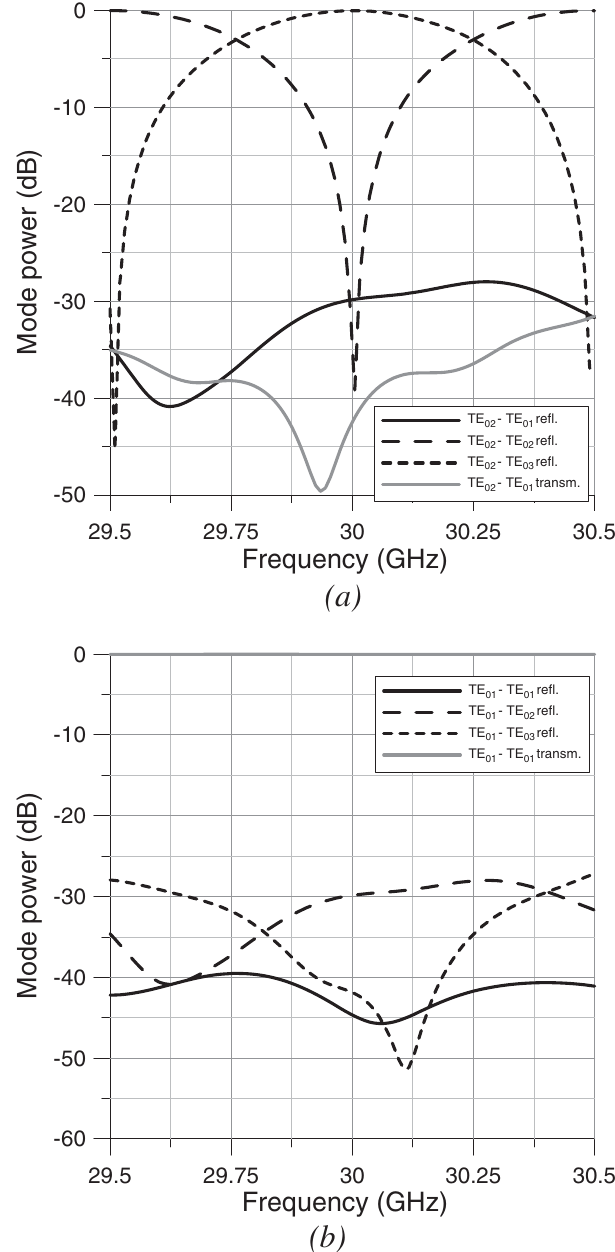
FIG. 9. Results of calculation of mode conversions in the $ TE mode reflecting converter: (a) with TE TE 01 02 mode incidence. incidence; (b) with TE 01